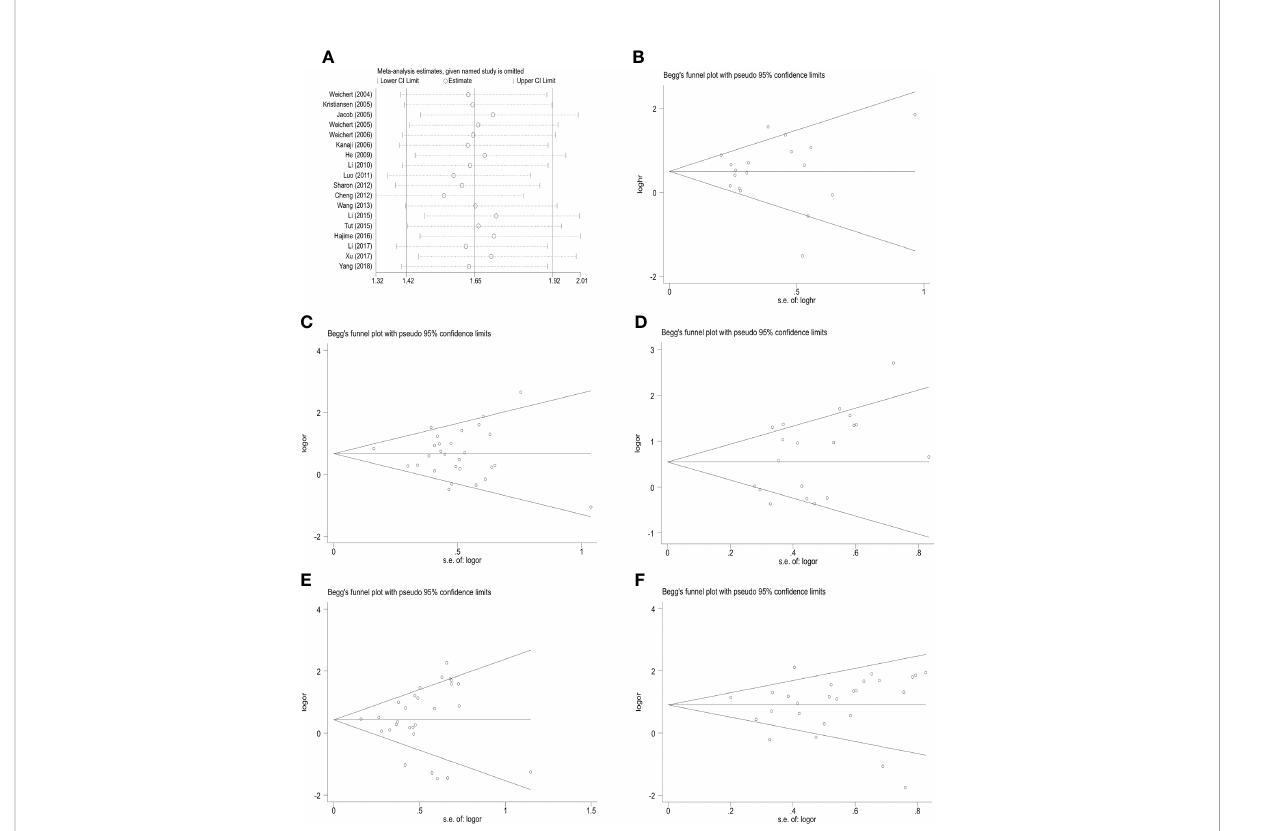
FIGURE 6 Sensitivity analysis and funnel plot for publication bias testing of the PLK-1 analyses and the clinicopathological parameters of cancer patients. (A) sensitivity analysis for 5-year overall survival; (B) publication bias plots for analyses of 5-year overall survival; (C) histological grade; (D) primary tumor grade; (E) lymph node metastasis; (F) clinical